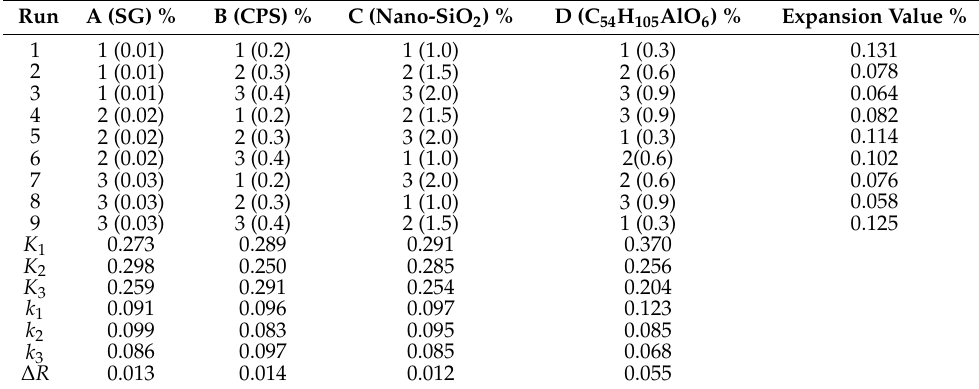
Table 1. Orthogonal scheme factor and horizontal distribution table.